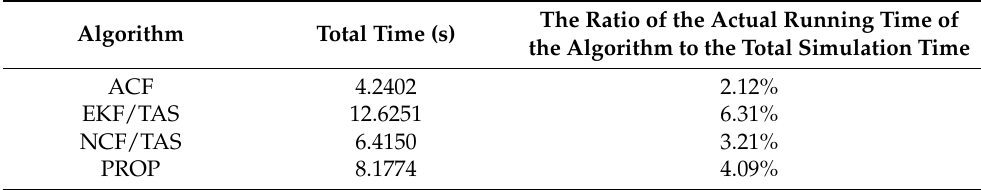
Table 6. Comparison of the computational efficiency among different